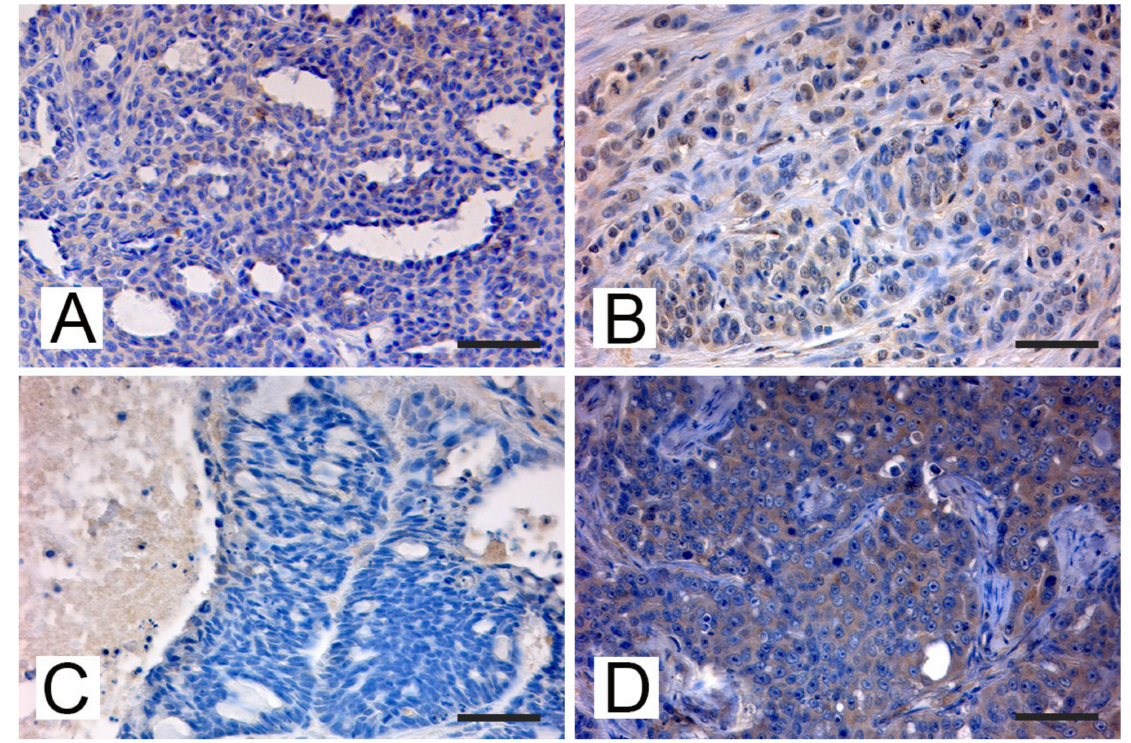
Figure 2. Cat. Mammary gland. Immunohistochemical expression of p14 MMTV env protein: ( A ) FMC # 84589 from Pisa, tubulopapillary carcinoma. Weak cytoplasmatic immunostaining in some neoplastic epithelial cells (bar = 50 µ m); ( B ) FMC #873/08, from Bologna, tubulopapillary carcinoma. Diffuse medium intense cytoplasmic and nuclear staining was detected in some neoplastic epithelial cells that were arranged cords and tubular structures and showed moderate to severe anisocytosis and anisokaryosis, with margination of the chromatin and prominent nucleoli. Mitoses are also present (bar = 50 µ m); ( C ) FMC # 259/00, from Bologna, ductal carcinoma. Scattered weak cytoplasmic staining was detected in some epithelial cells arranged in cords and tubules surrounding lumina showing anisocytosis and anisokaryosis (bar = 50 µ m); ( D ) FMC #28983, from Bologna, tubulopapillary carcinoma. Diffuse intense cytoplasmic staining of neoplastic cells arranged in tubular and papillary structures showing significant anisocytosis and anisokaryosis, margination of